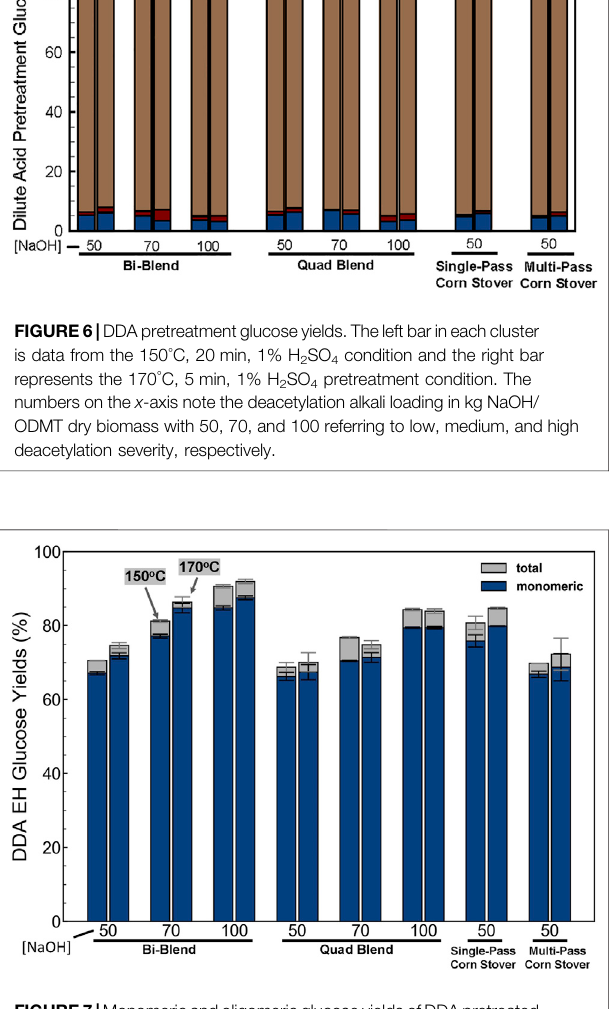
FIGURE7| MonomericandoligomericglucoseyieldsofDDApretreated feedstocks after high-solids enzymatic hydrolysis. The left bar in each cluster is data from the 150 ° C, 20 min, 1% H 2 SO 4 condition and the right bar represents the 170 ° C, 5 min, 1% H 2 SO 4 pretreatment condition. The numbersonthe x -axisnotethedeacetylationalkaliloadinginkgNaOH/ODMT biomasswith50,70,and100referringtolow,medium,andhighdeacetylation severity, respectively. The enzymatic hydrolysis was conducted at an enzyme loading of 12 mg total protein/g glucan using an 80:20 mixture of Novozymes CellicCTec3/HTec3 at50 ° Cand20%totalsolidsloadingfor7 days.Barsand error bars show the average and the standard deviation, respectively, of two replicated experiments.